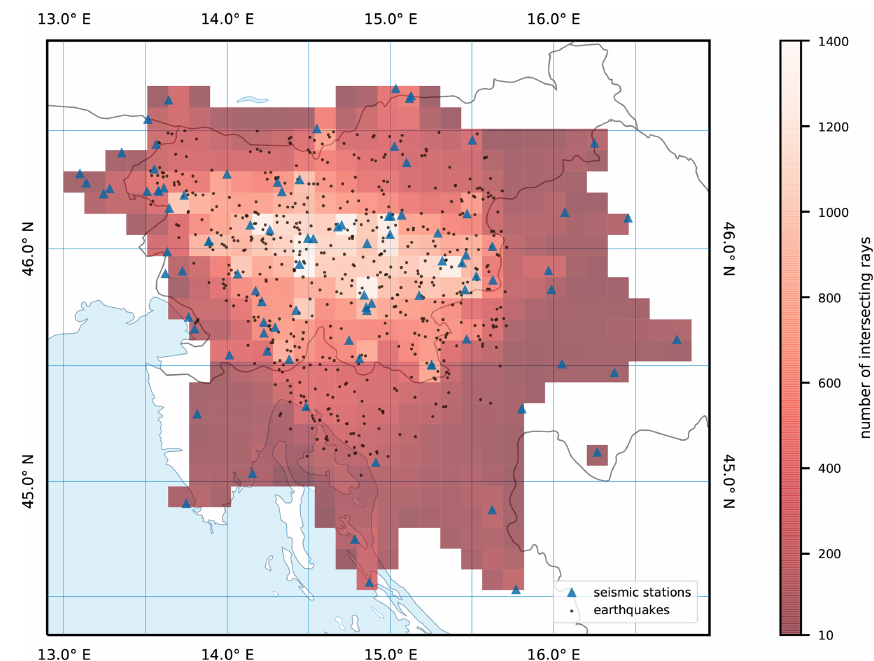
Figure 4. Number of great-circle rays intersecting square 10km grid elements and connecting earthquake–station pairs for the earthquakes shown in Fig. 3. Grid elements with less than 10 intersecting rays are not